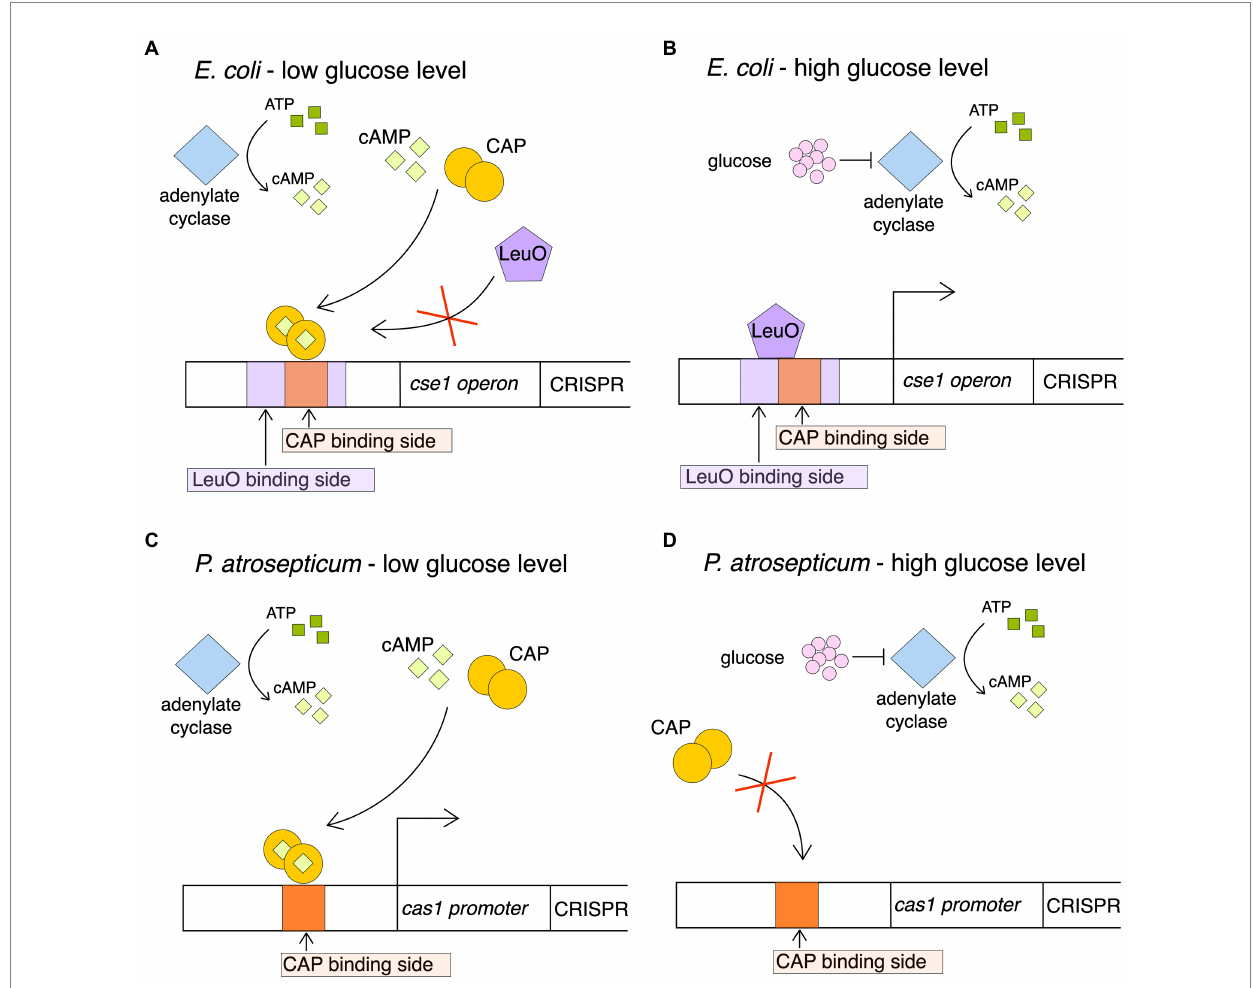
FIGURE 3 The regulation mechanism of cAMP-CAP in E. coli in a low glucose concentration (A) , transcription of the cas genes and CRISPR array is repressed by binding of the cAMP-CAP complex. Binding of the complex prevents binding of the protein LeuO, which is a positive transcription regulator. On the other hand, increasing concentration of glucose (B) results in a decrease in the number of active complexes, which cannot compete with LeuO in binding to the LeuO binding side. The bound LeuO protein activates the transcription of the cas genes and the CRISPR RNA precursor (pre-crRNA). The regulation mechanism of cAMP-CAP in P. atrosepticum in a low glucose concentration (C) , low glucose concentration results in the activation of adenylate cyclase, which is involved in the conversion of ATP to cAMP. CAP, which is a positive regulator of the cas operon, binds to its target sequence only in the presence of cAMP. The cAMP-CAP complex binds to the cas gene promoter and activates the cas operon. High glucose concentration (D) , transcription of cas genes is repressed by the glucose phosphotransferase system and more specifically by adenylate cyclase. The lack of cyclase means that ATP is not converted to cAMP, and thus the active cAMP-CAP complex is not formed, which negatively regulates the transcription of cas1